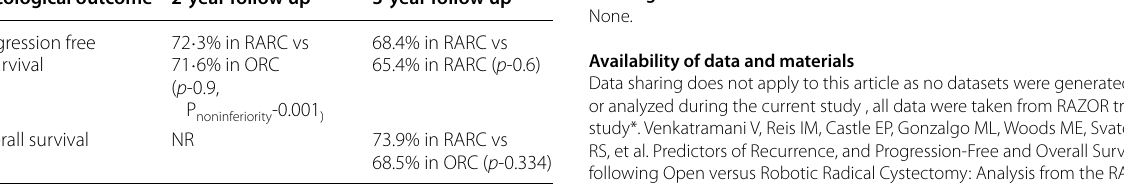
Table 1 Comparing oncological outcome after 2-year and 3-year follow-up Oncological outcome 2-year follow up 3-year follow up Progression free survival Overall RARC robot-assisted radical cystectomy, ORC Open radical cystectomy, NR not reported